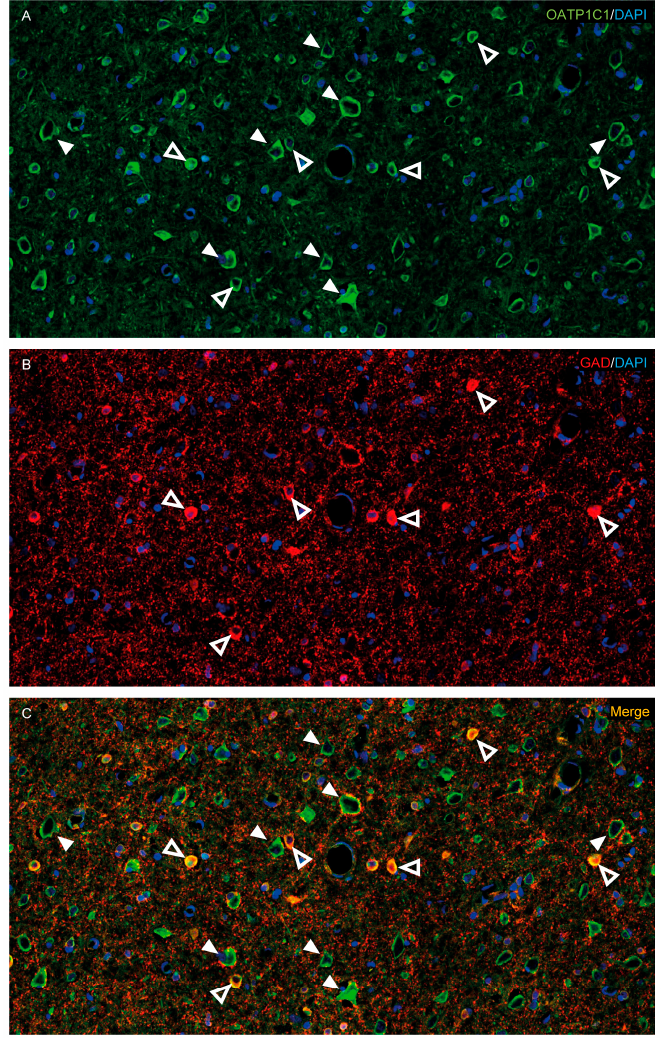
Figure 5. Expression of OATP1C1 in the macaque cortical GABAergic neurons. Confocal tile scan microscope images of a macaque cortical section double-stained for OATP1C1 (green, A ) and the interneuronal marker GAD (red, B ). ( C ) Merged image showing the colocalization of both markers only in small cells surrounding pyramidal neurons. Counterstaining with DAPI (blue) shows nuclei of all cells. White arrowheads point to pyramidal neurons. Hollow white arrowheads point to double-labeled interneurons. Note that OATP1C1 is expressed in practically all GAD-immunopositive neurons. GAD: glutamic acid decarboxylase. Scale bar = 100 μ m.